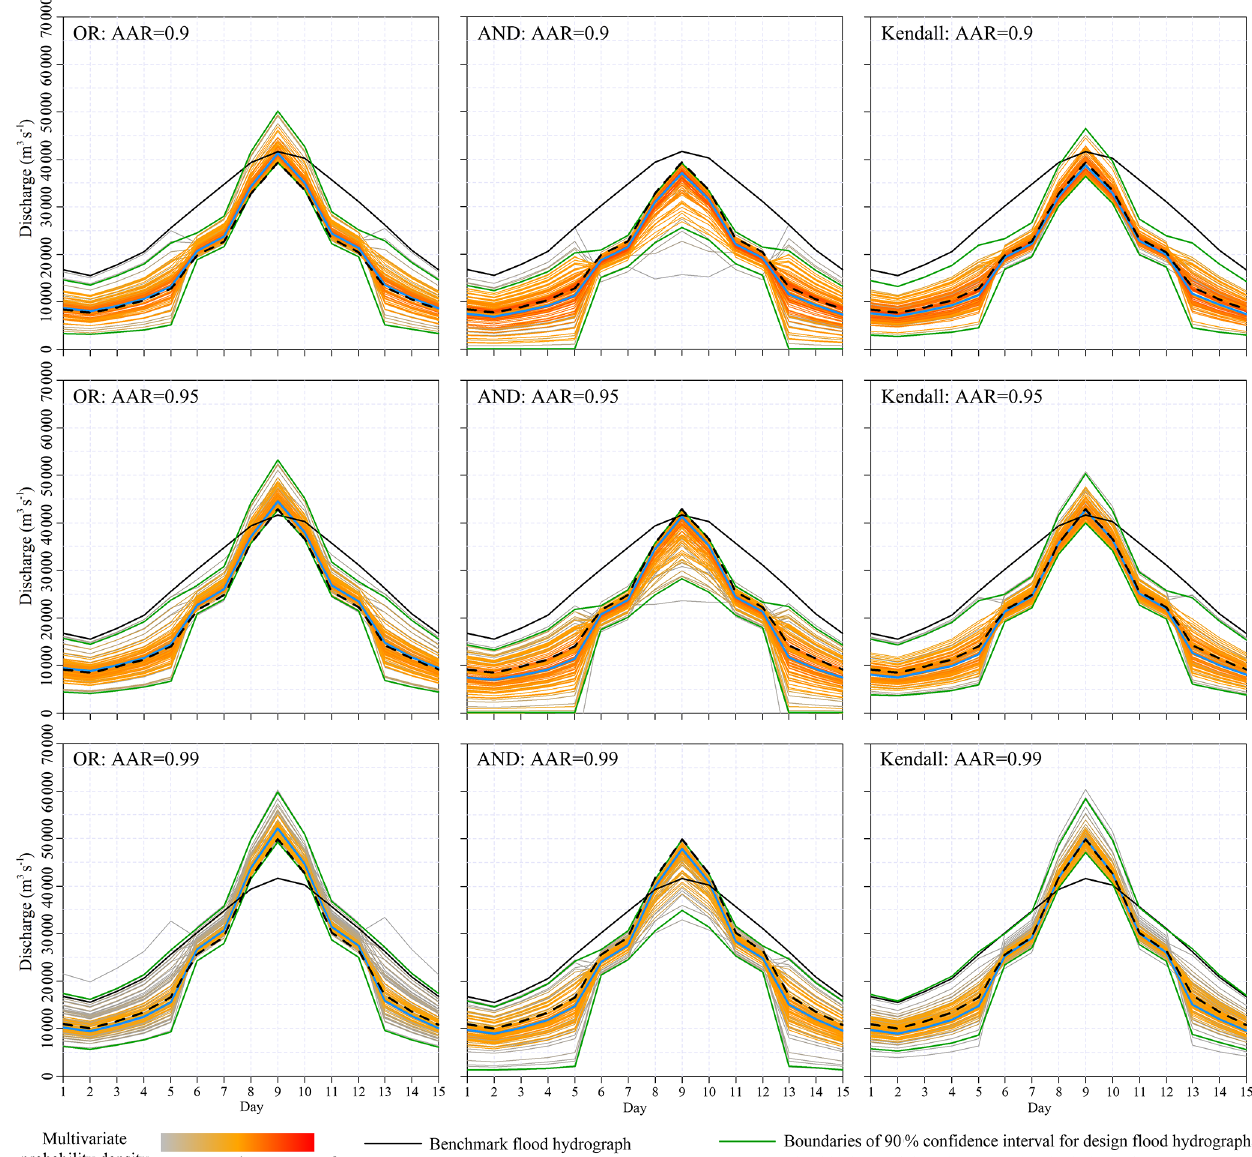
Figure 11. Design flood hydrographs associated with OR, AND and Kendall